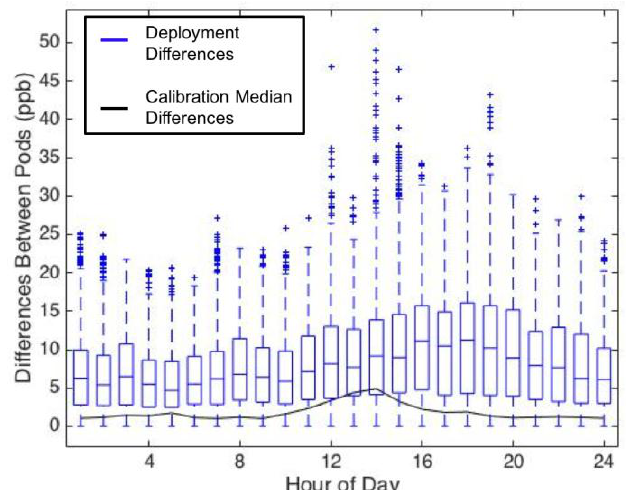
Figure 5. Differences between all campus UPods binned by hour, with differences displayed as absolute ppb. The graphic includes the boxplot of the differences during the deployment (blue outlined boxes), and the median differences of the calibration data (solid black line). Whisker lines (blue) encompass 1.5 times the IQR, and outliers (blue crosses) indicate data points lying outside 1.5 times the IQR of the deployment data.